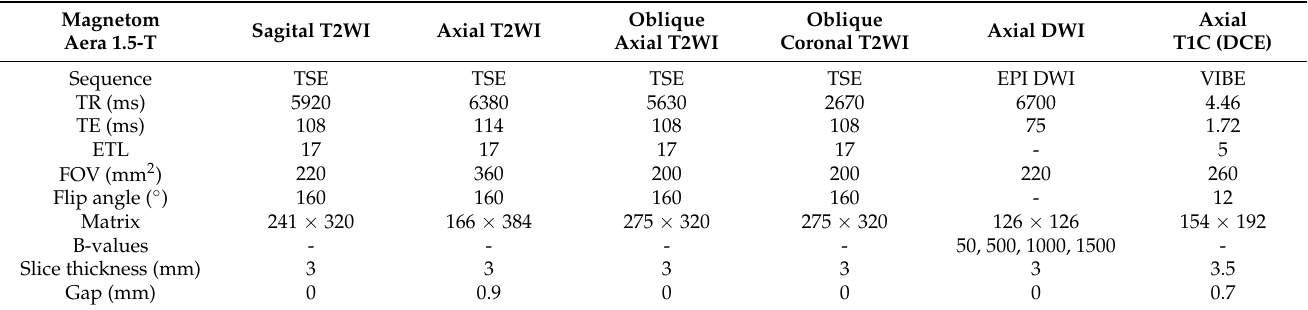
Table 1. Restaging pelvic MRI acquisition